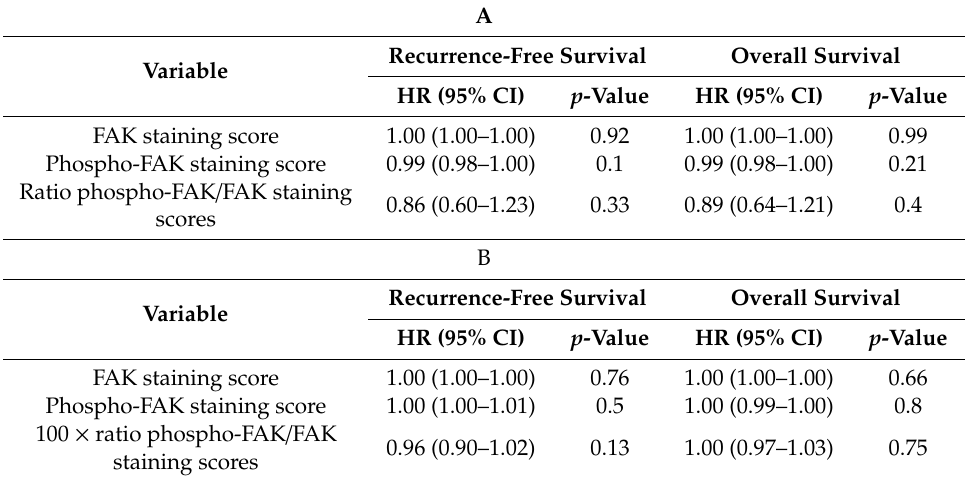
Table 2. Correlation of FAK and phospho-FAK expression with recurrence-free survival and overall survival in (A) NSCLC and (B) SCLC patients in a univariate analysis.